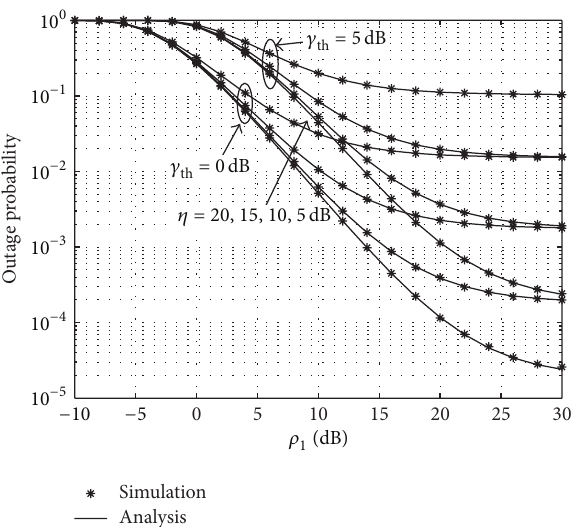
Figure 6: Comparison of AF relaying system with MRC/MRT and DF relaying system with MRT versus 𝑁 ( 𝜌 1 = 𝜌 2 = 0 dB, 𝜌 𝑅,𝑖 = = 0 dB, ∀𝑖 , 𝑗 , 𝛾 = 0 dB). 𝜌 𝐷,𝑗 th